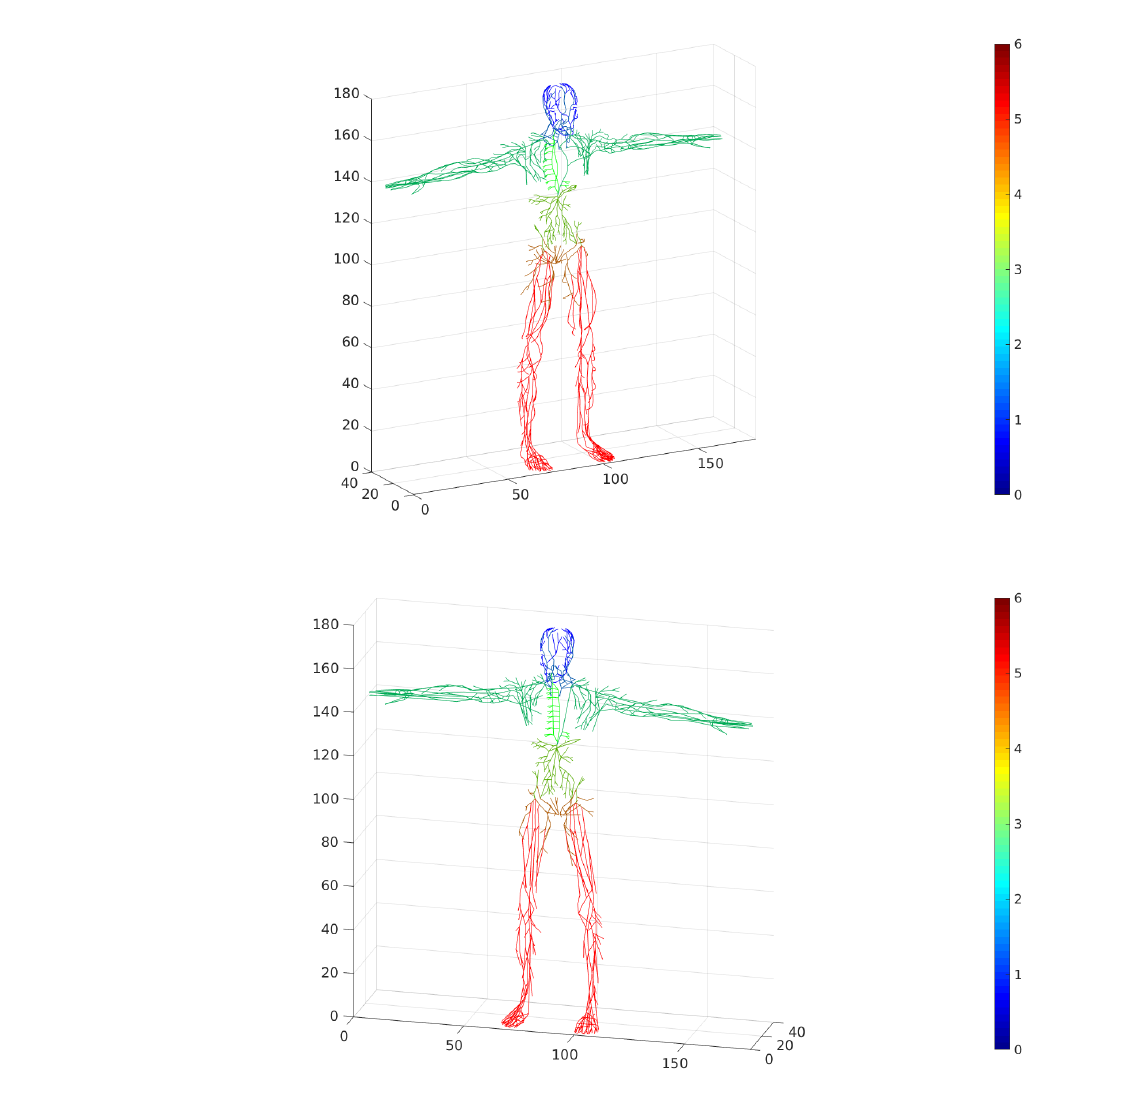
Figure 14. Anatomically-clustered vessel groups. Lymphatic vessel groups’ color code numbering refers to the following: head (0), neck (1), arms (2), chest (3), trunk (4), waist (5), legs (6). ( Top ) Basis network graph; ( Bottom ) skeleton network